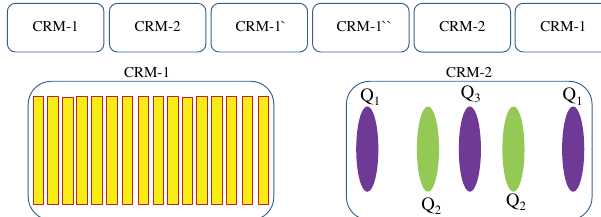
FIG. 13. The layout of the TCAV-based dechirper at 1 GeV which fits inside six cryomodules. Cryomodules 1, 3, 4, and 6 have 16 13-cell cavities (shown in yellow). Cryomodules 2 and 5 host negative drift beam lines designed of focusing (green) and defocusing (purple) quadrupoles in respect to the ( x , x 0 ) phase space.